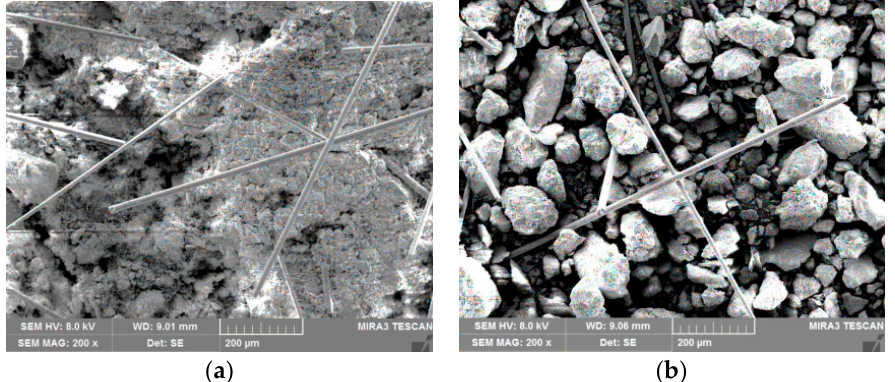
Figure 9. Fiber-network structure in BFRT: ( a ) tailings clay with 0.6% fiber content, ( b ) tailings sand with 0.4% fiber content.